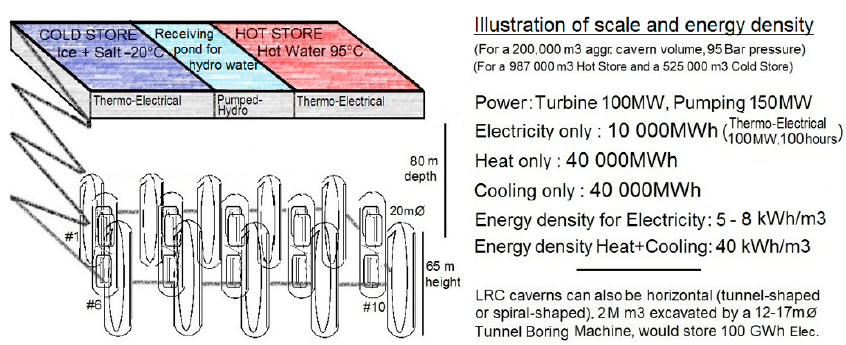
Figure 11. Illustrations of scale and of energy density for the UPHES-PTES storage.